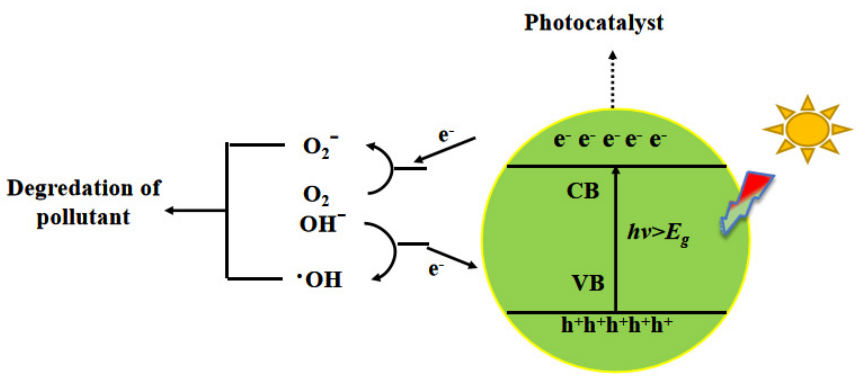
Figure 1. Schematic diagram of g-C 3 N 4 photocatalysis.